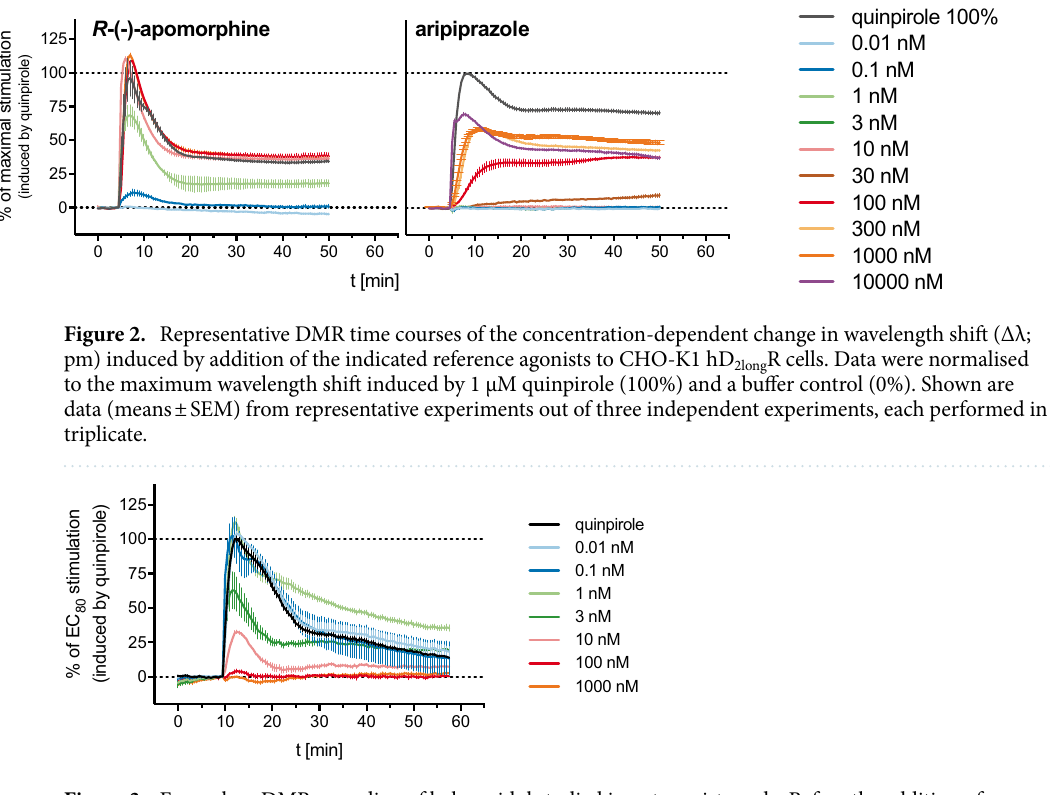
Figure 3. Exemplary DMR recording of haloperidol studied in antagonist mode. Before the addition of quinpirole at a concentration eliciting 80% of the maximal response (30 nM), the cells were incubated with varying concentrations of haloperidol for 30 min. Data were normalised to the maximum wavelength shift induced by 30 nM quinpirole (100%) and a buffer control (0%). Data represent means ± SEM from three independent experiments, each performed in